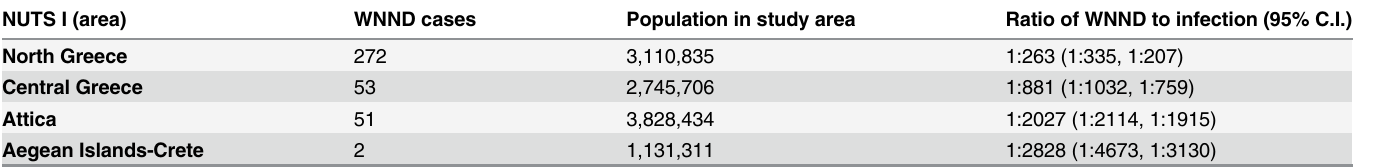
Table 5. Ratio of West Nile neuroinvasive disease (WNND) to infection by NUTS I area. NUTS I (area)